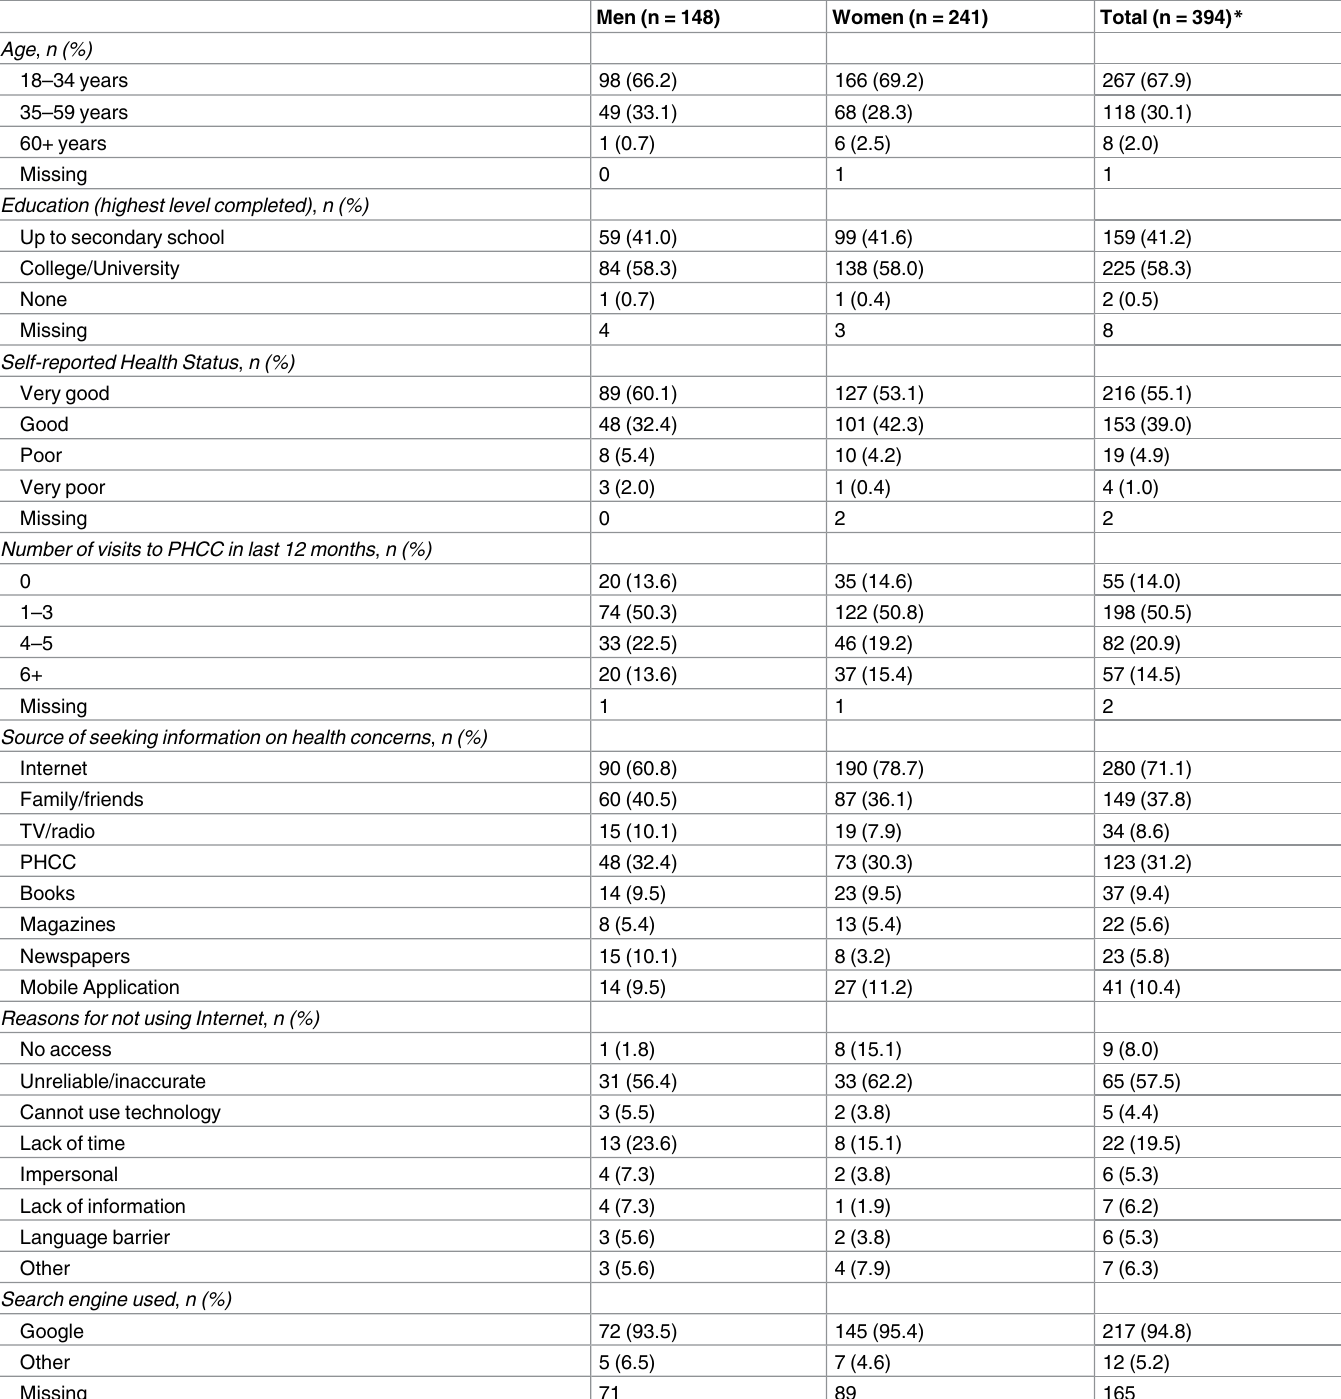
Table 1. Study sample characteristics of 394 Adult Qatari participants, according to